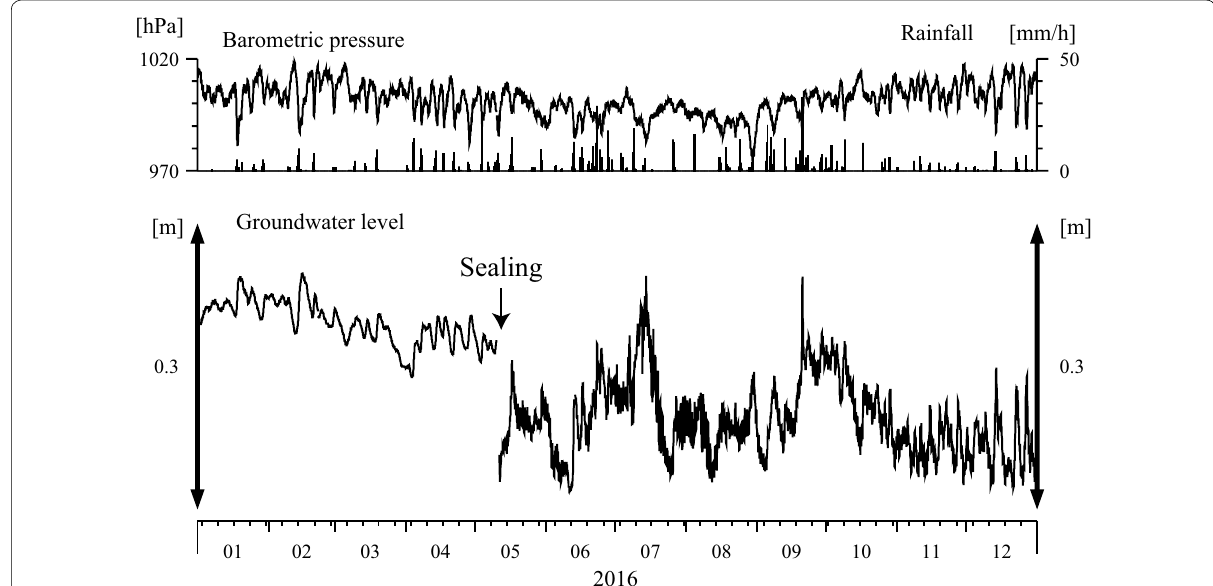
Fig. 3 Observation results at HKS in 2016. Observed groundwater level changes, barometric pressure, and rainfall (bars in top plot) are shown. The inner pipe was sealed in May 2016. Barometric pressure and rainfall are refer to left and right scales,